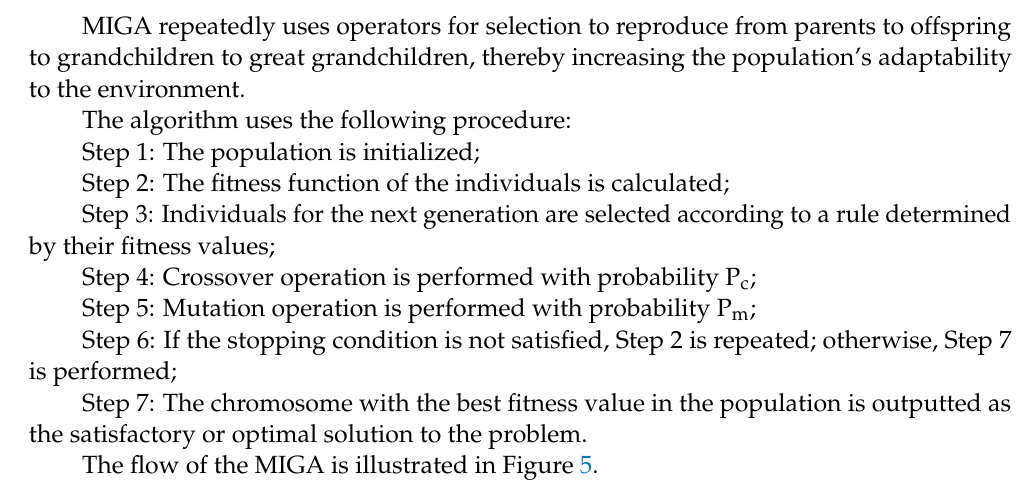
Figure 4. Principle of population division.